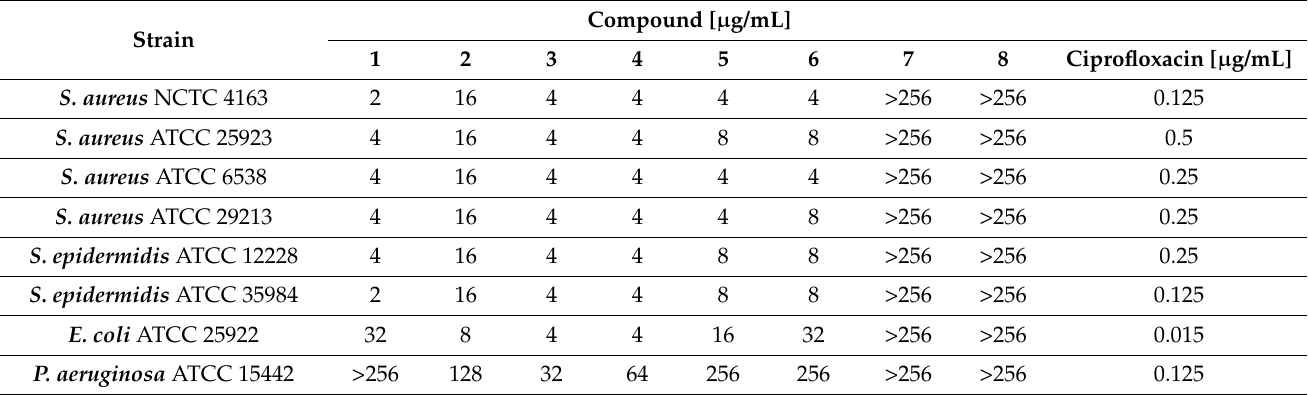
Table 2. Activity of Ciprofloxacin menthol derivatives against standard bacteria strains, expressed by minimal inhibitory concentrations ( µ g/mL).